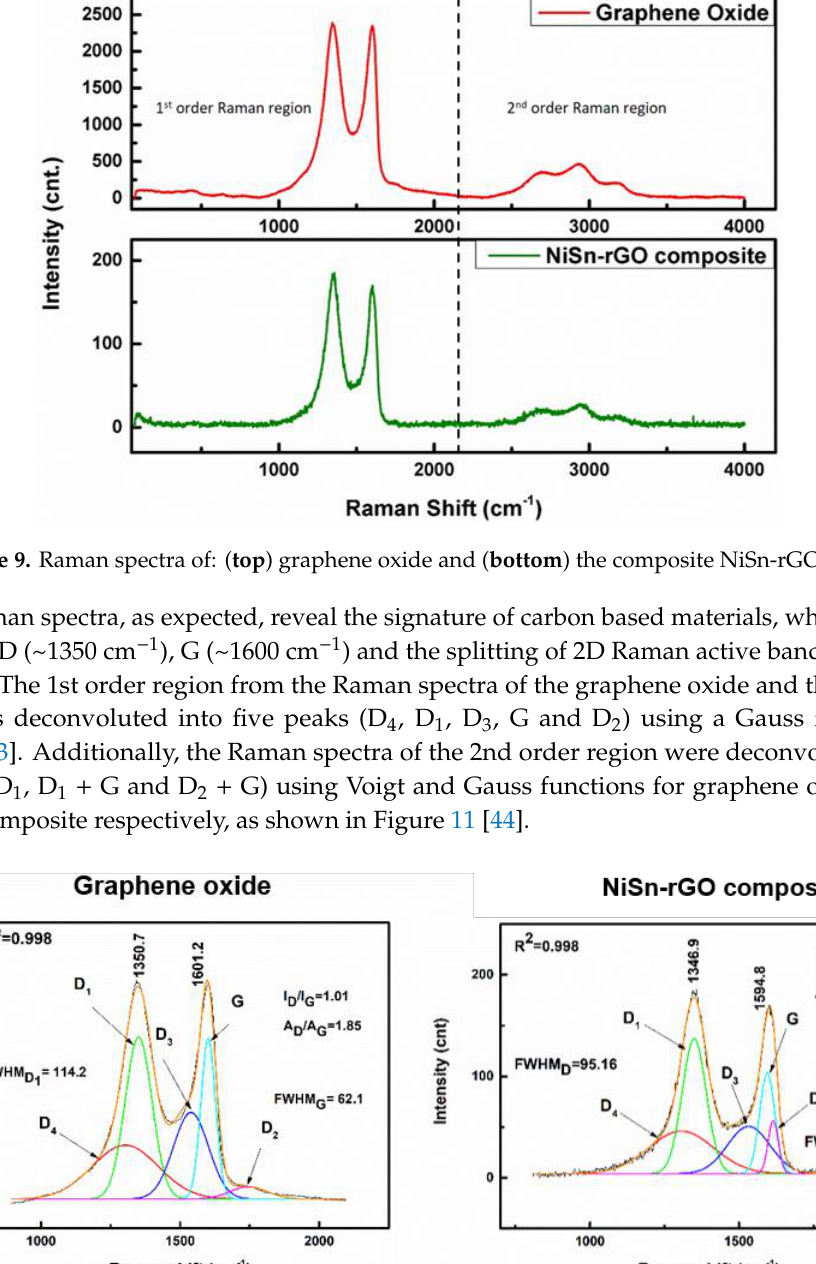
Figure 10. Deconvolution of the peaks from the 1st order Raman region of the signal emitted by graphene oxide and the NiSn-rGO-P3.3 composite. The sum of the deconvolution is marked with an orange